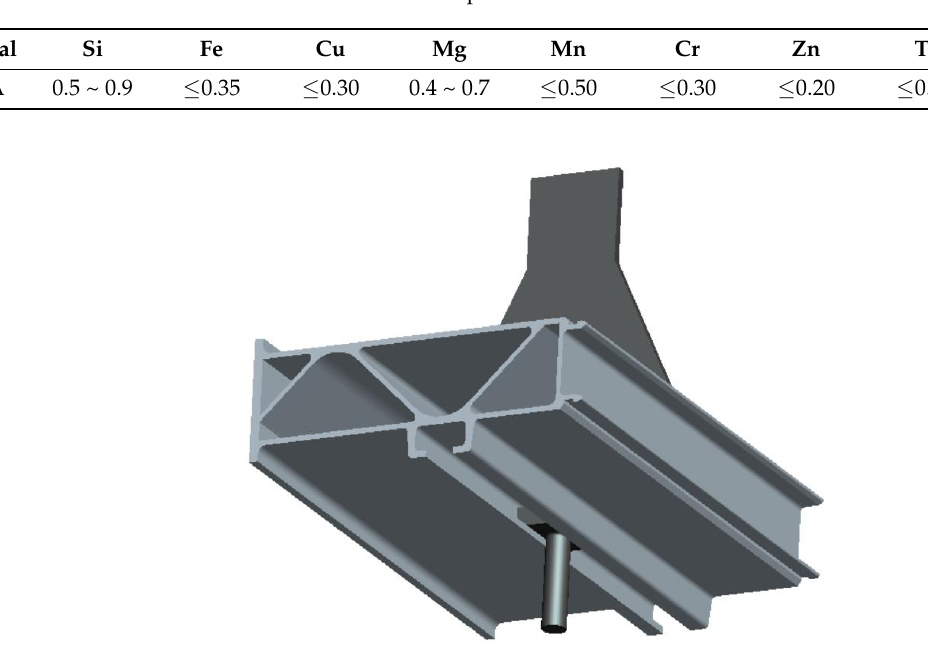
Table 2. Chemical composition of the structure material.